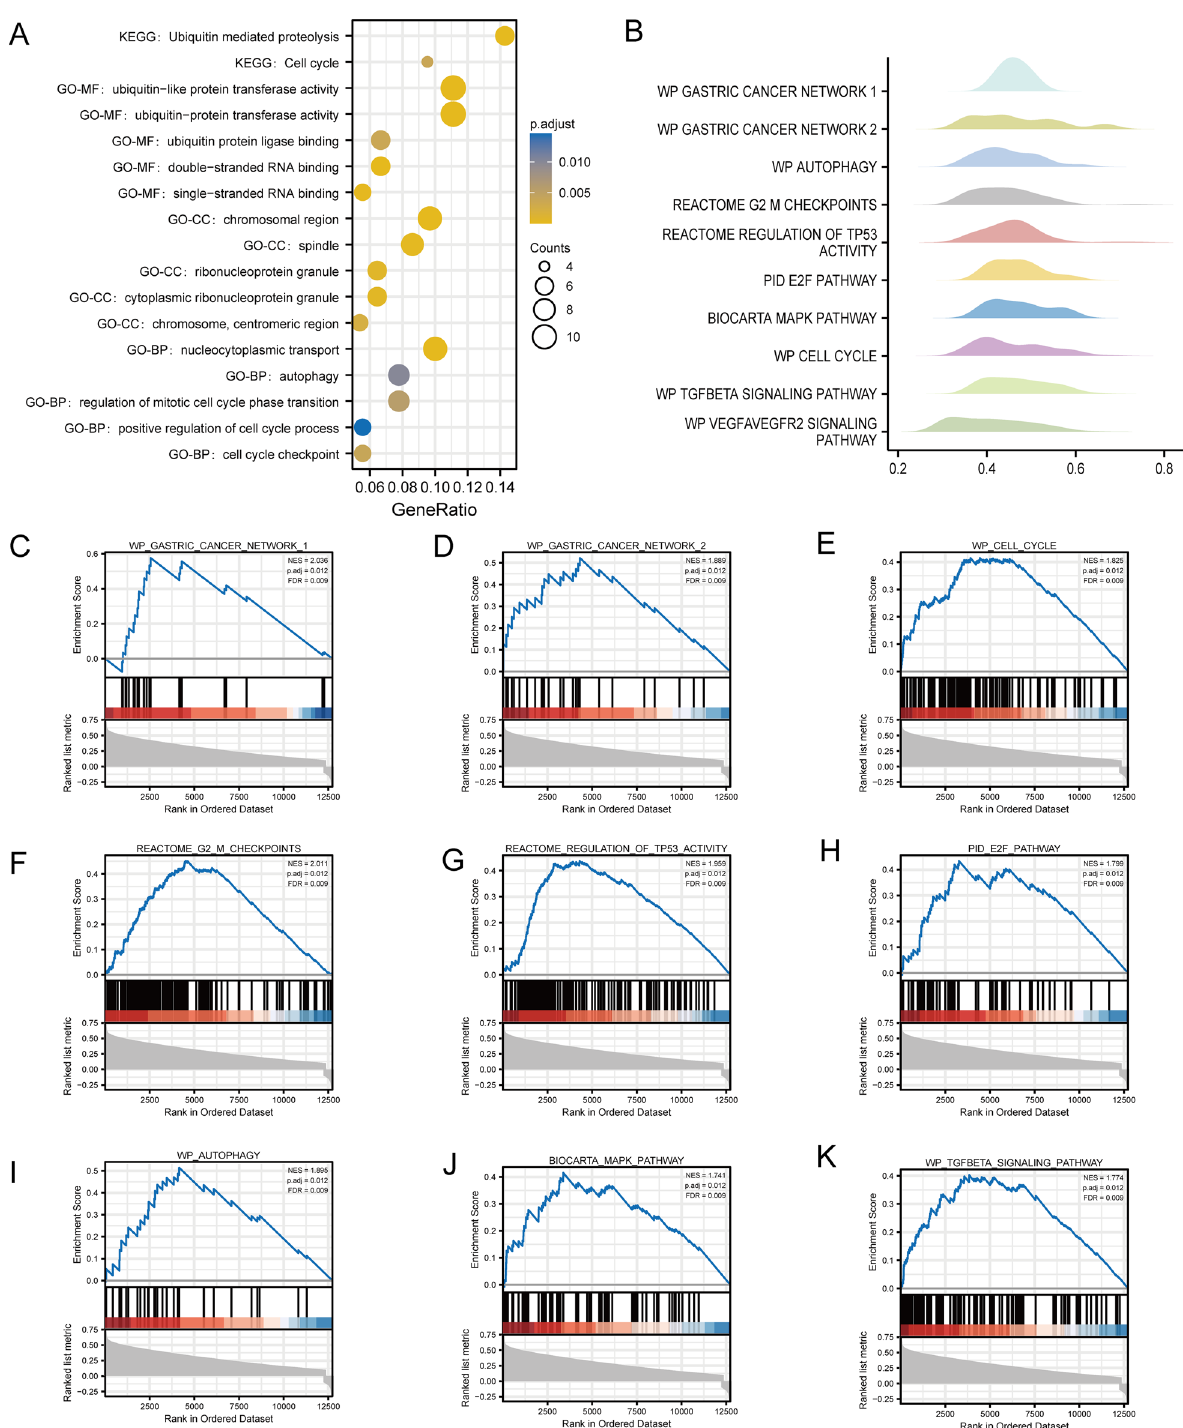
Figure 4. Functional enrichment analysis of OSGIN2-related genes ( A ) GO + KEGG 70–72 functional enrichment analysis of DEGs and visualization of bubble diagram. ( B ) GSEA enrichment analysis was performed on DEGs, and 10 datasets related to gastric cancer were selected to depict mountain maps for visualization. ( C–K ) Dataset- specific enrichment score results related to gastric cancer in GSEA enrichment analysis